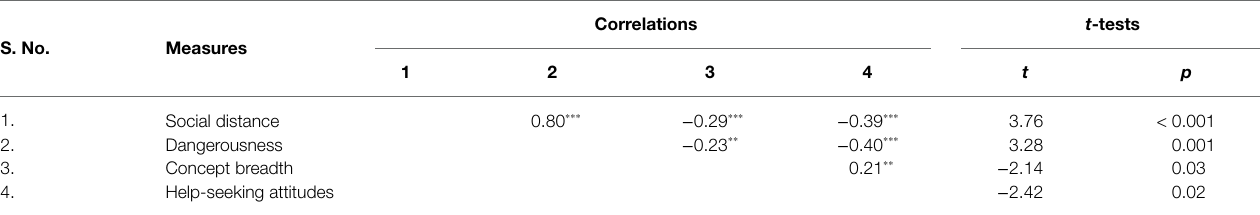
TABLE 3 | Pearson correlations and independent sample t -tests comparing groups for stigma, concept breadth, and help-seeking attitudes.